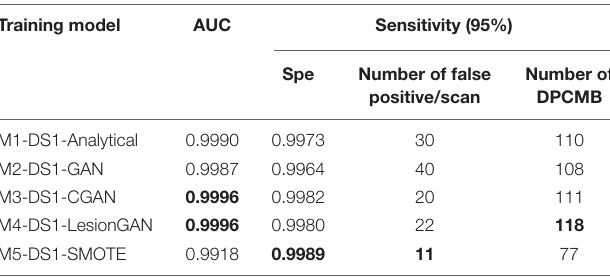
TABLE 3 | Results of cerebral microbleed (CMB) classification on the whole SWI training on 20,000 samples and test on the DS1. Training